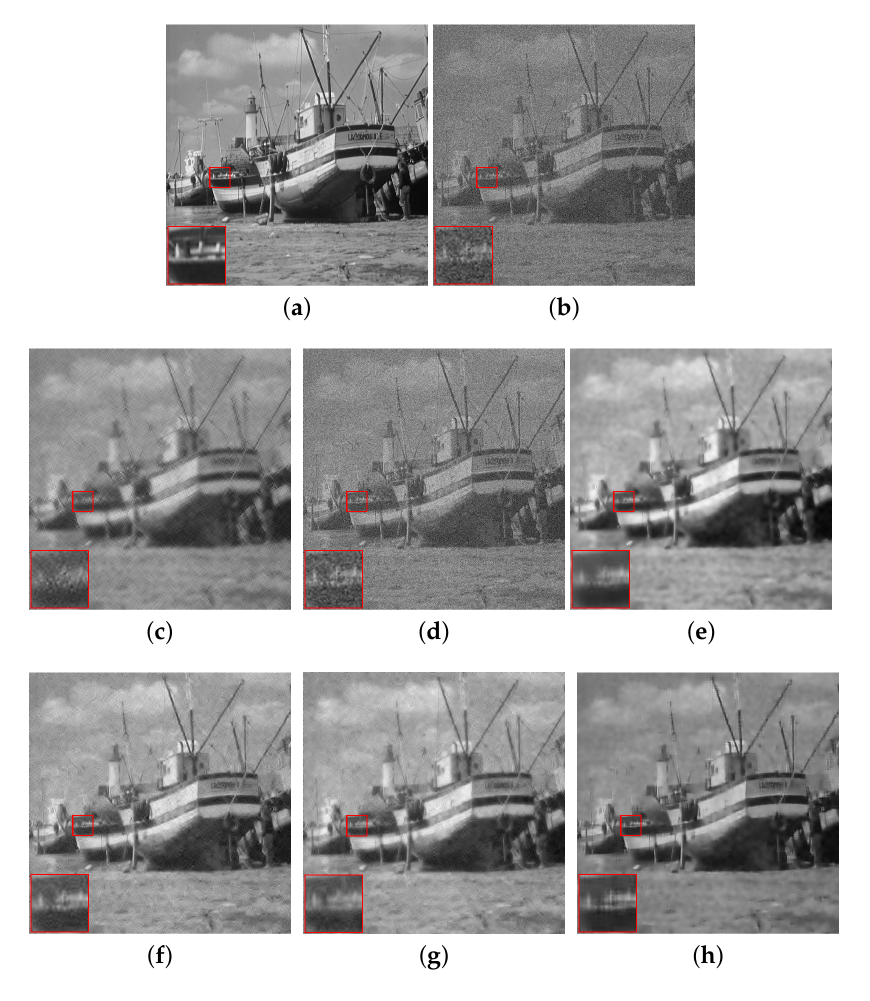
Figure 6. Comparison of the denoising results (PSNR/SSIM) of all the algorithms on the standard boat image with σ = 45, where s = 10. ( a ) Original image; ( b ) noise image ( σ = 45); ( c ) SG-HT (22.62/0.4135); ( d ) OMP (16.77/0.2176); ( e ) GraSP (24.42/0.6146); ( f ) SVRGHT (24.68/0.5172); ( g ) LSSG-HT (25.51/0.5321); ( h ) SRGSP